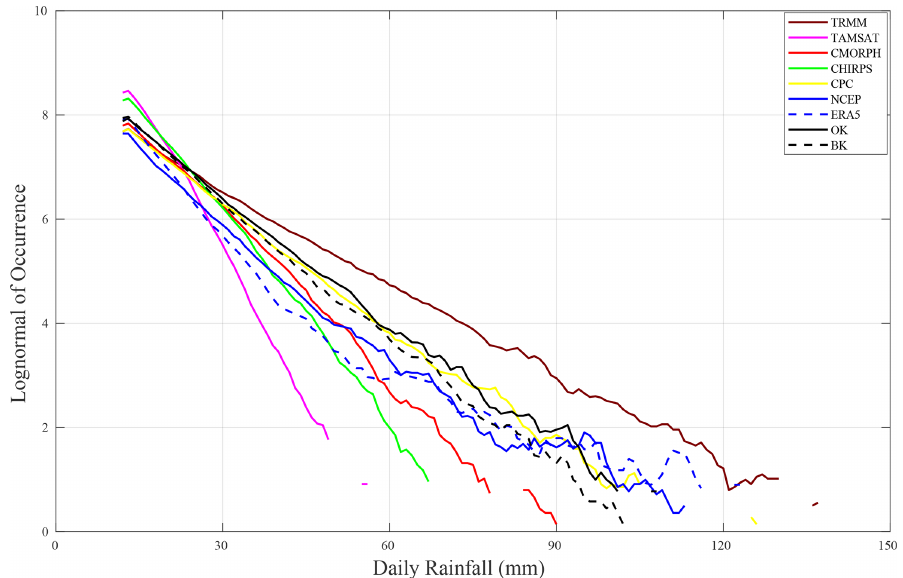
Figure 12. Comparison of the logarithmic distribution of daily rainfall amounts recorded in each grid point over the common period between datasets for Senegal (1998–2010): TRMM, TAMSAT, CMORPH, CHIRPS, CPC, NCEP, ERA5, BK, and OK. Details of the datasets are provided in Table